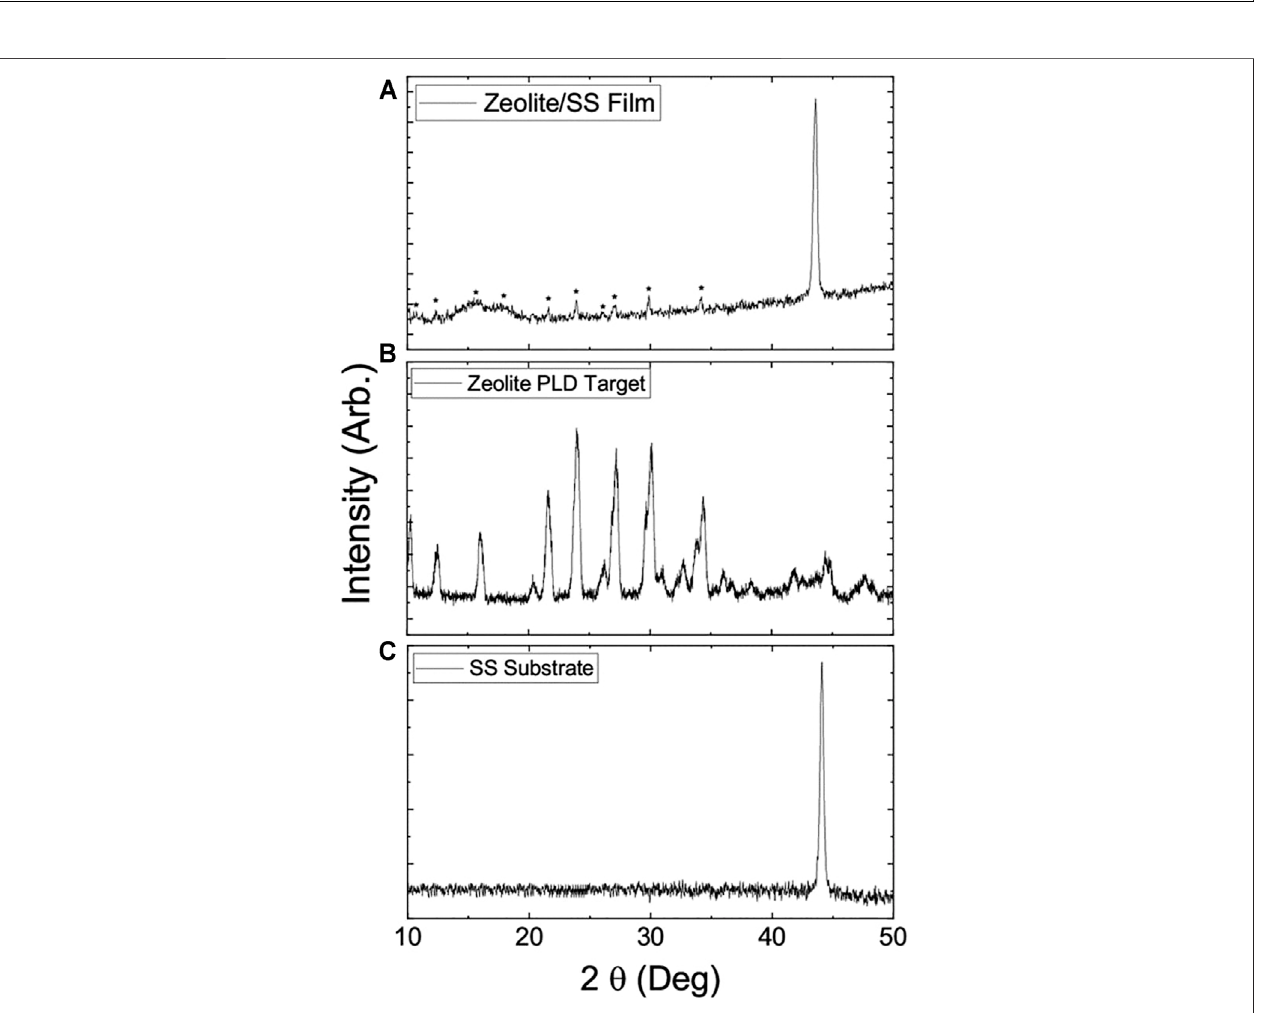
FIGURE 2 | X-ray diffraction spectrum of (A) zeolite-coated laser-structured SS meshes (peaks that belong to zeolite are marked with “ * ” ). (B) Zeolite target for pulsed laser deposition (PLD). (C) SS-100 substrate. The thickness of the fi lm used is 800 nm.